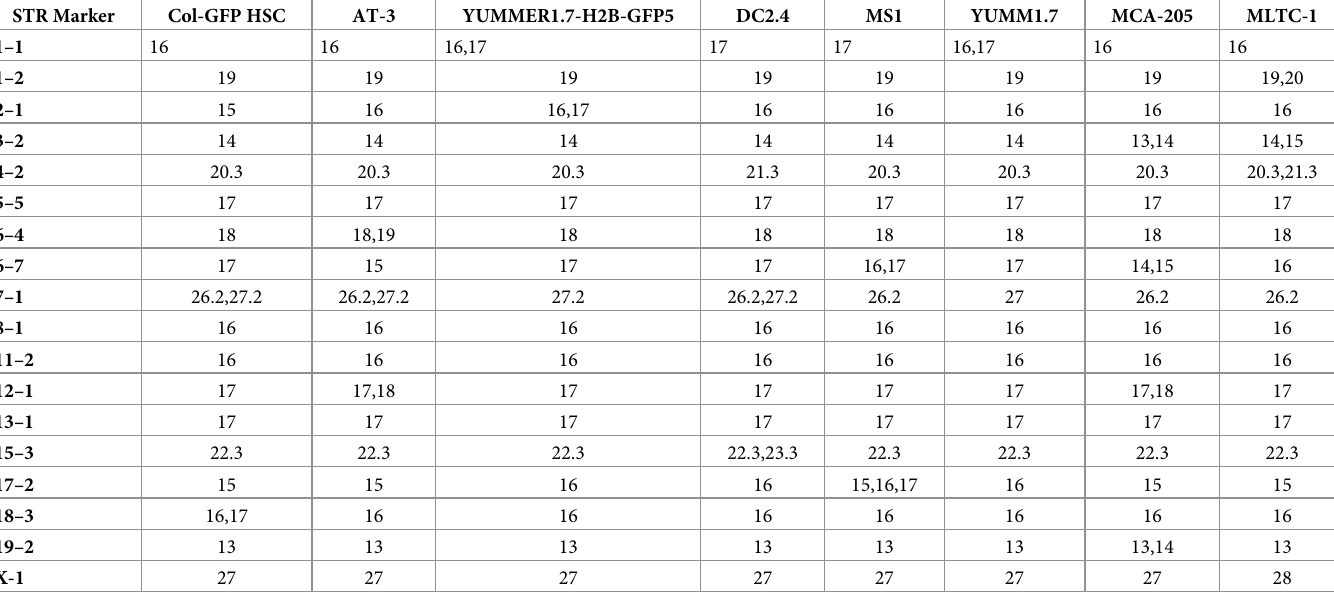
Table 3. CLASTR matching algorithm results for mouse STR profiles most similar to Col-GFP HSC to known STR profiles listed in Cellosaurus database �